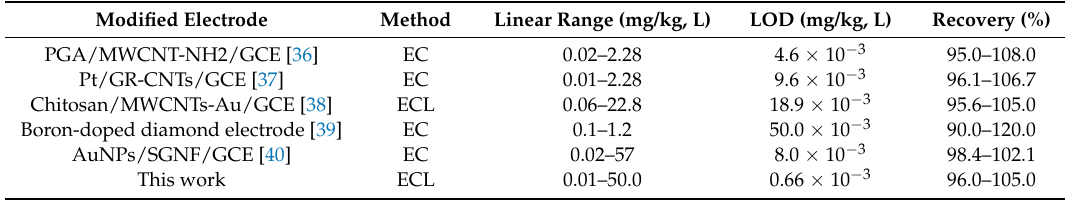
Table 2. Comparison of the performance for the BPA determination with others.